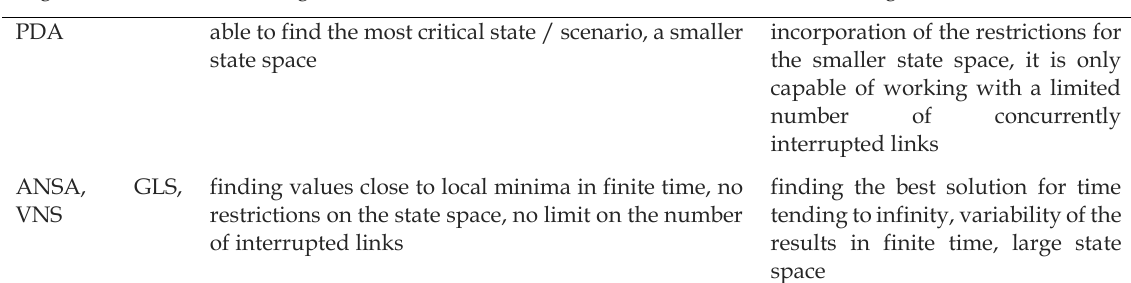
Advantages and disadvantages of the